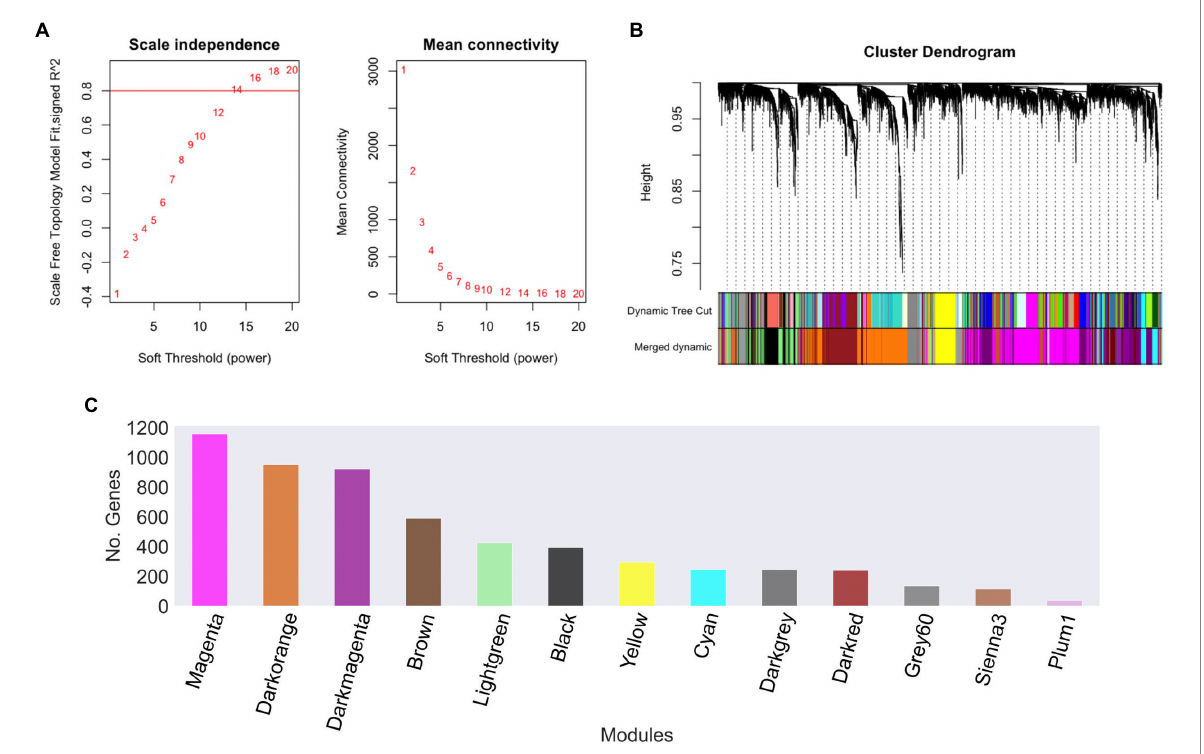
FIGURE 2 Ustilago maydis co-expression modules. (A) Scale independence and mean connectivity of network topology for different soft-thresholding, (B) A module hierarchical clustering tree was constructed based on the correlation of the amount of expression among genes. Each color corresponds to the genes belonging to the same module in the cluster tree, (C) The number of genes in each module. The grey module was removed because it is reserved to genes that are not part of any module.